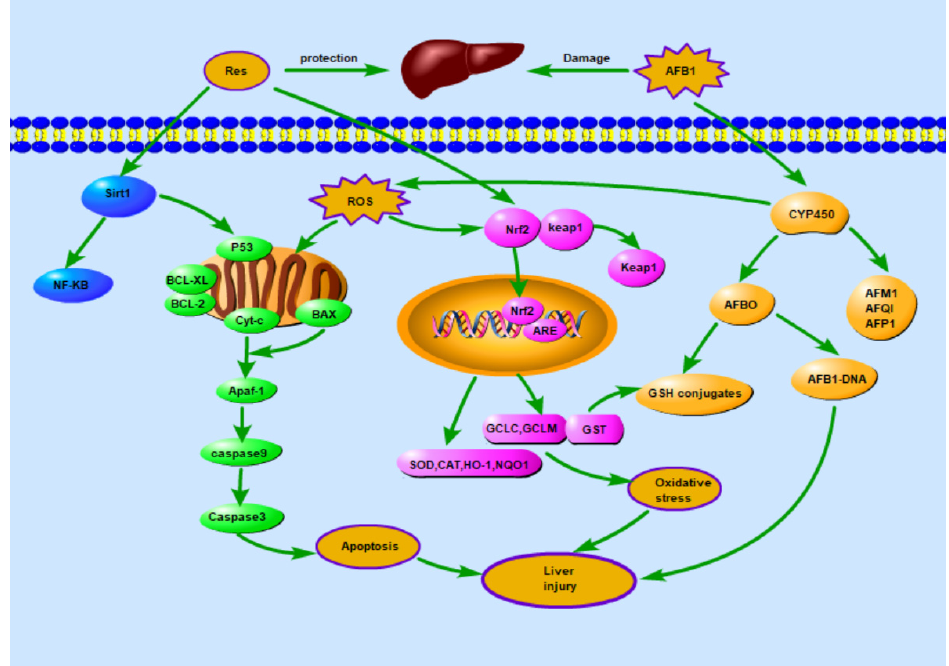
Figure 10. Res activated the Nrf2 pathway and inhibited mitochondrial apoptosis pathway to alleviate liver damage induced by AFB1.